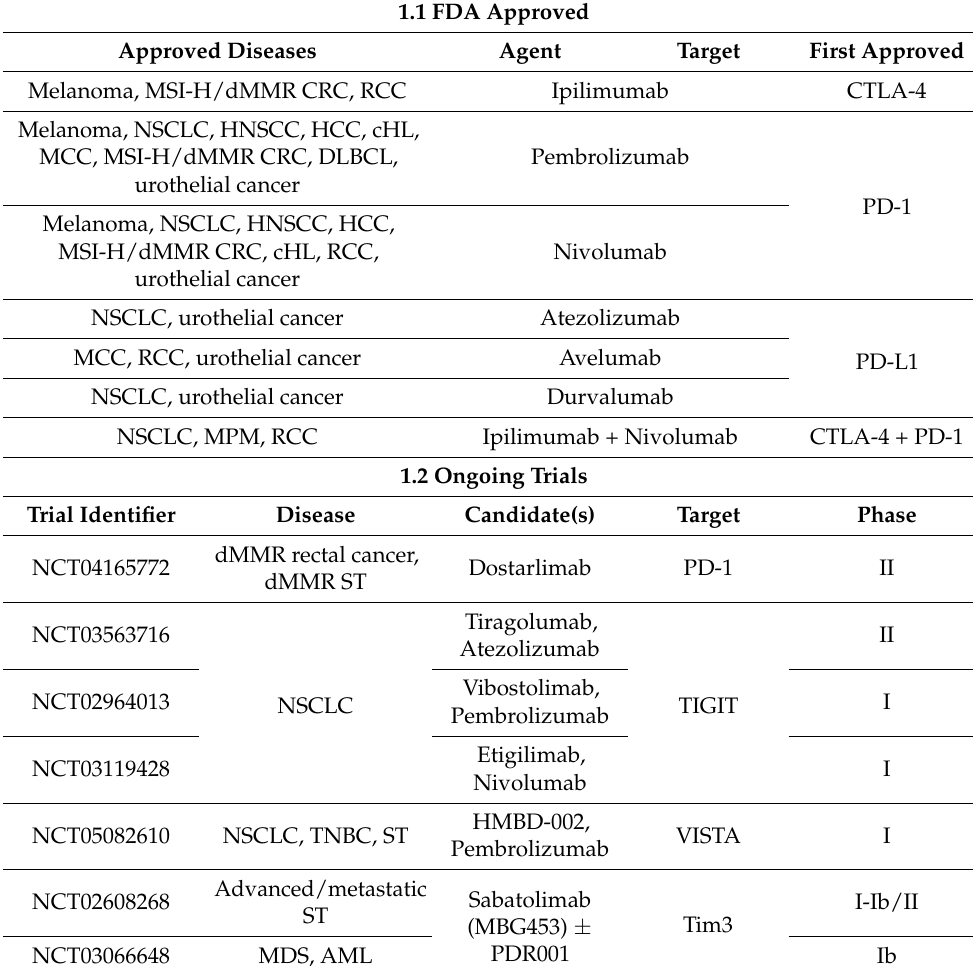
Table 1. FDA approved, combination and ongoing clinical trials with